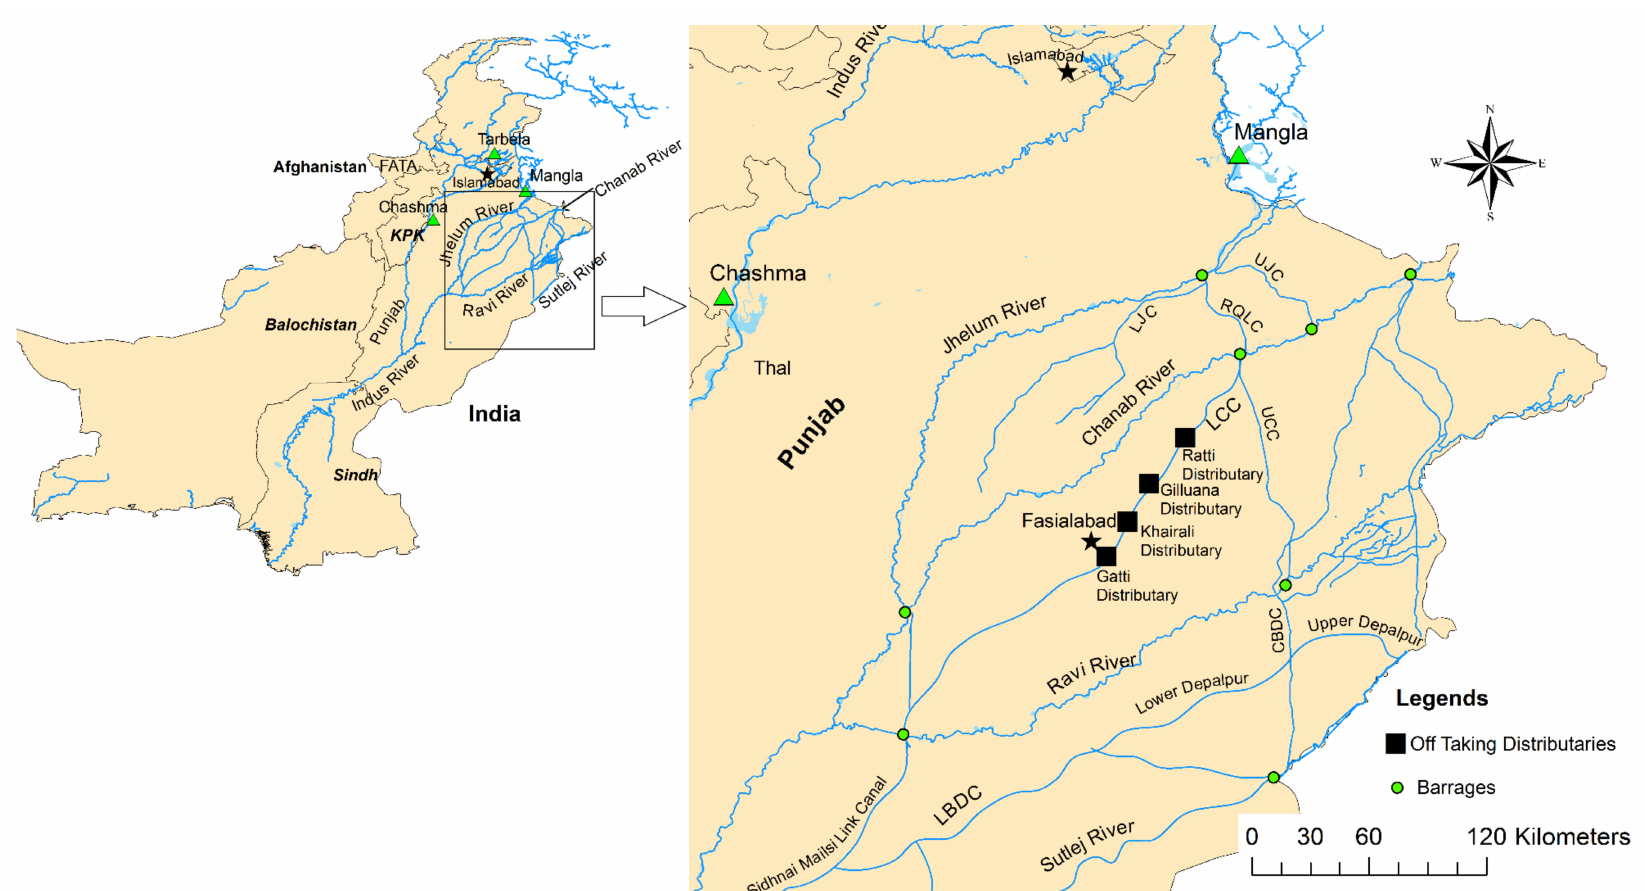
Figure 2. Map of the case study